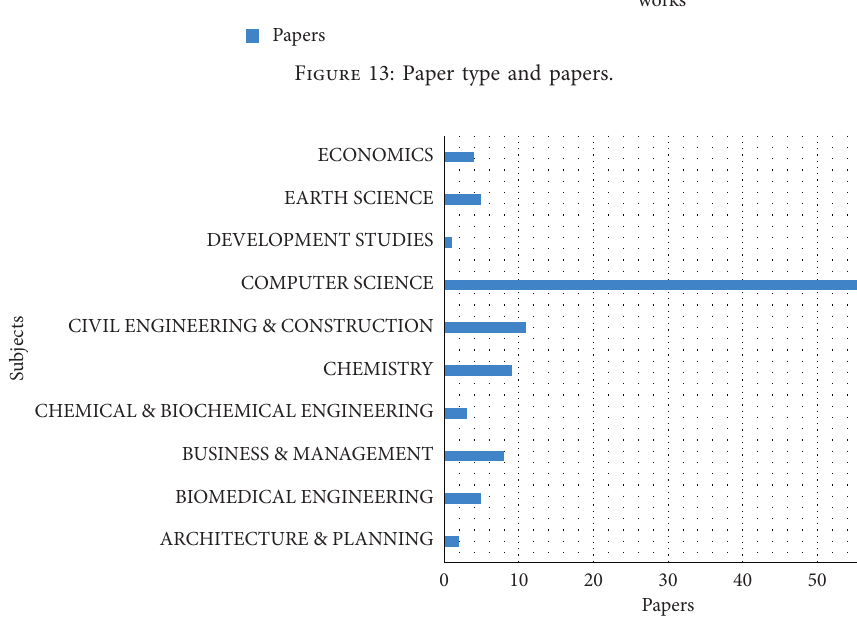
Figure 14: Subjects and papers.